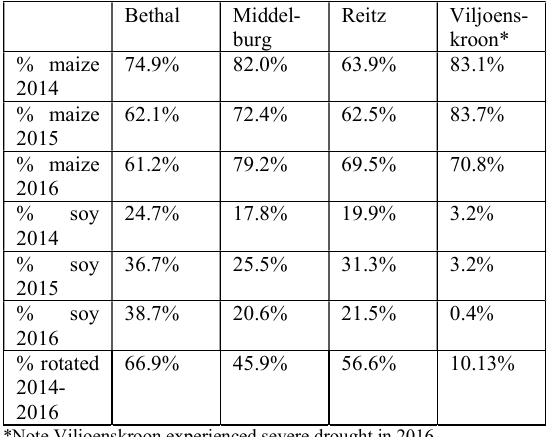
Table 1. The percentage of cultivation of maize and soybeans per year and percentage area that were rotated between maize and soybeans for 4 districts